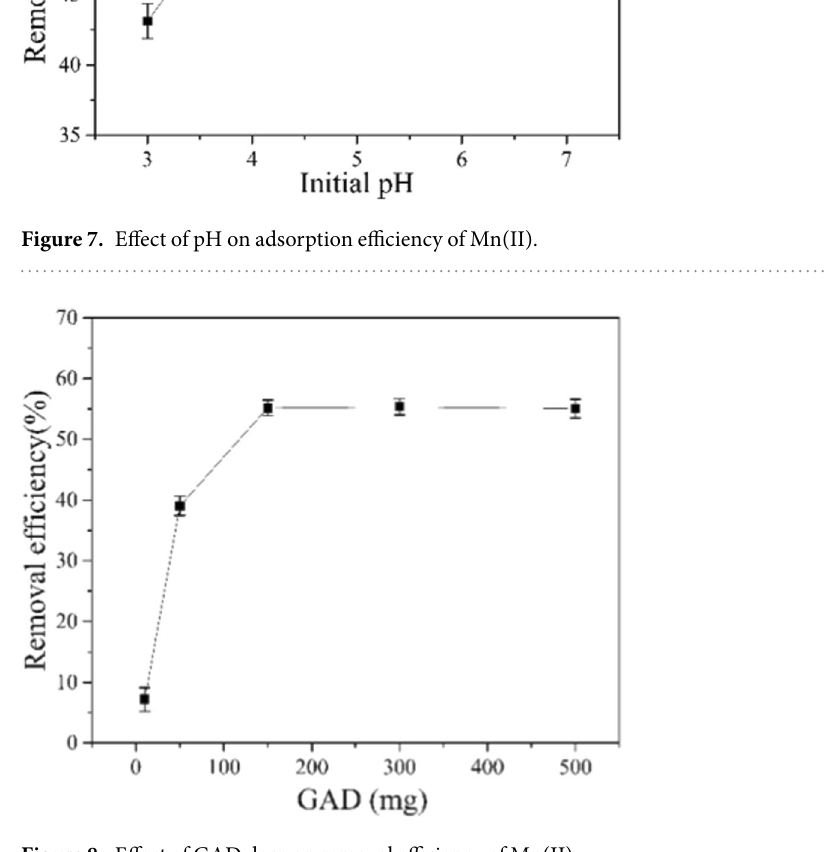
Figure 8. Effect of GAD dose on removal efficiency of